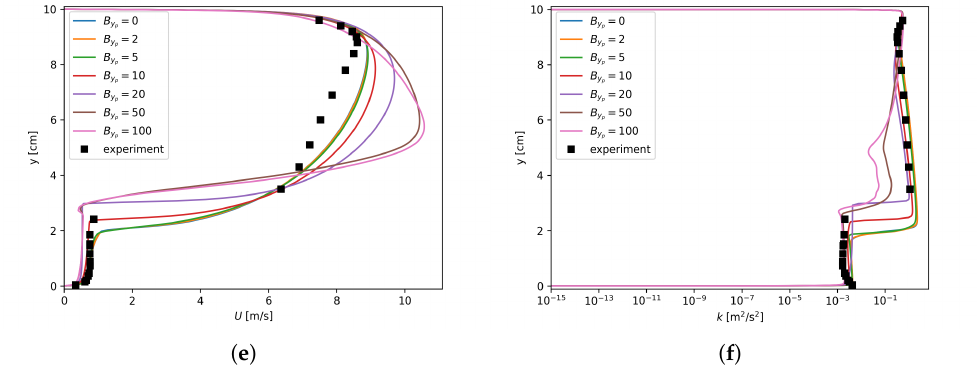
µ 2 g with δ = − ρ l , ρ g p µ 2 l